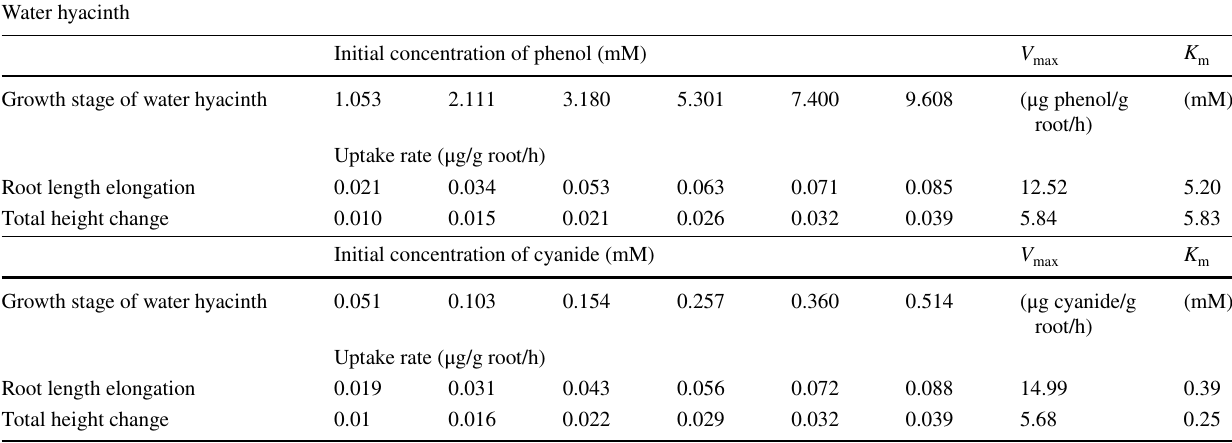
Table 5 Values of Vmax and Km for phenol and cyanide uptake equation at different growth stages of Eichhornia crassipes Water